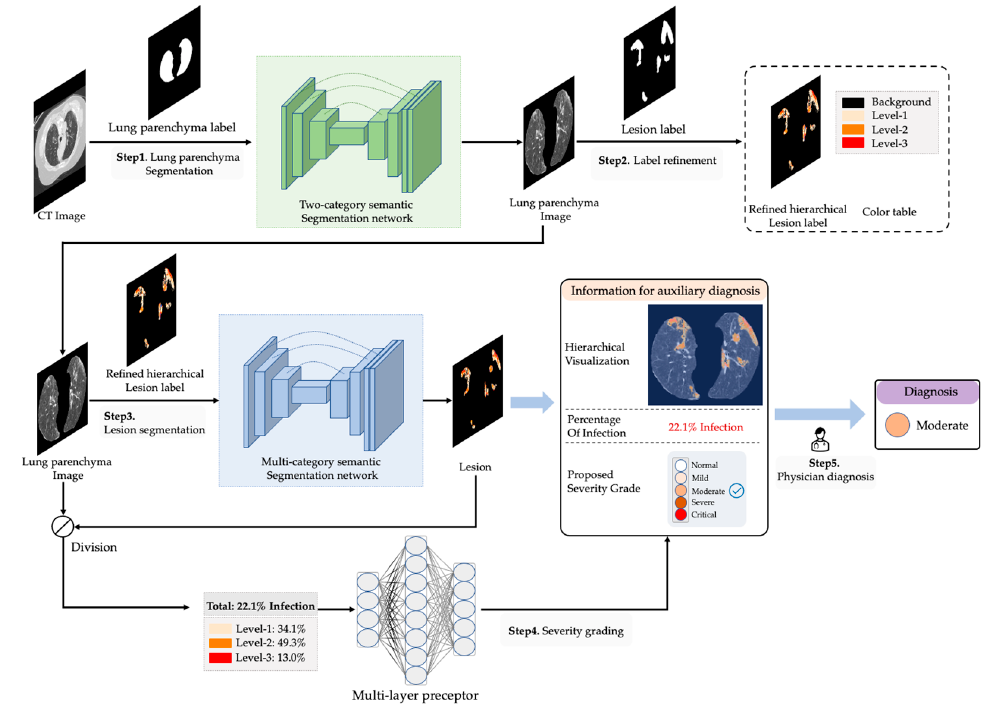
Figure 1. The full workflow of the proposed auxiliary diagnosis system.